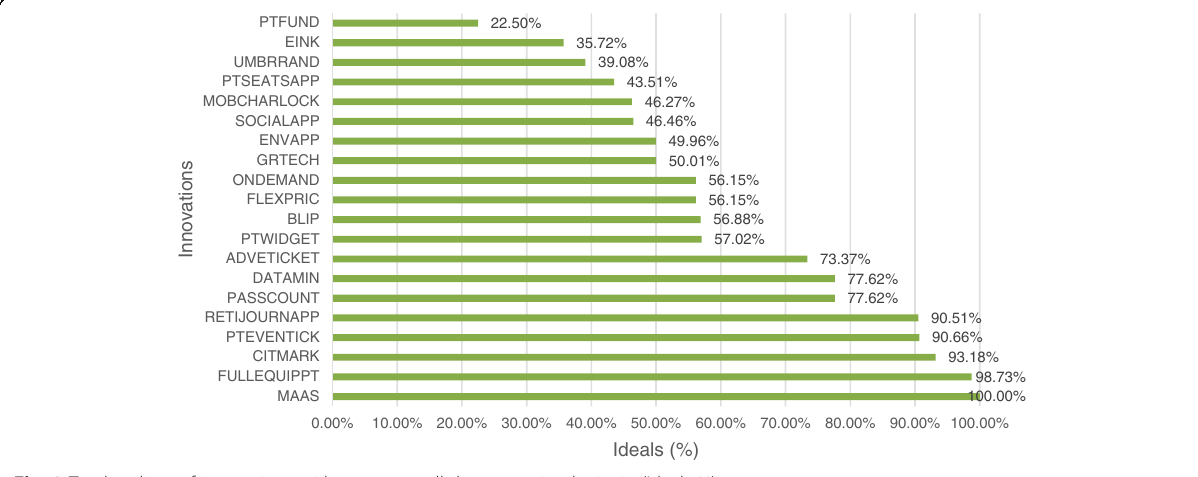
Fig. 3 Total ranking of innovations with respect to all three examined criteria (Ideals